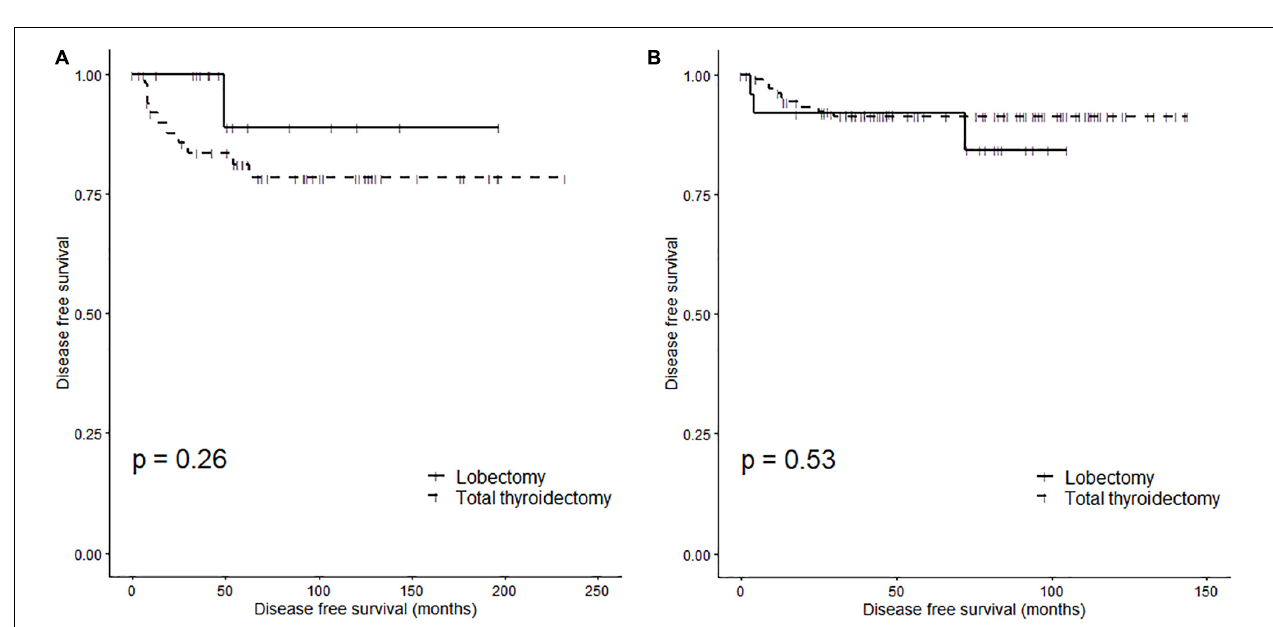
FIGURE 3 | Disease-free survival rates of subgroups according to surgery type: (A) pediatric patients (log rank p = 0.26) and (B) adult patients (log rank p = 0.53).